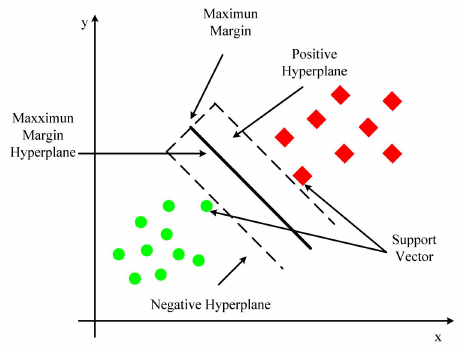
Figure 5. Support vector